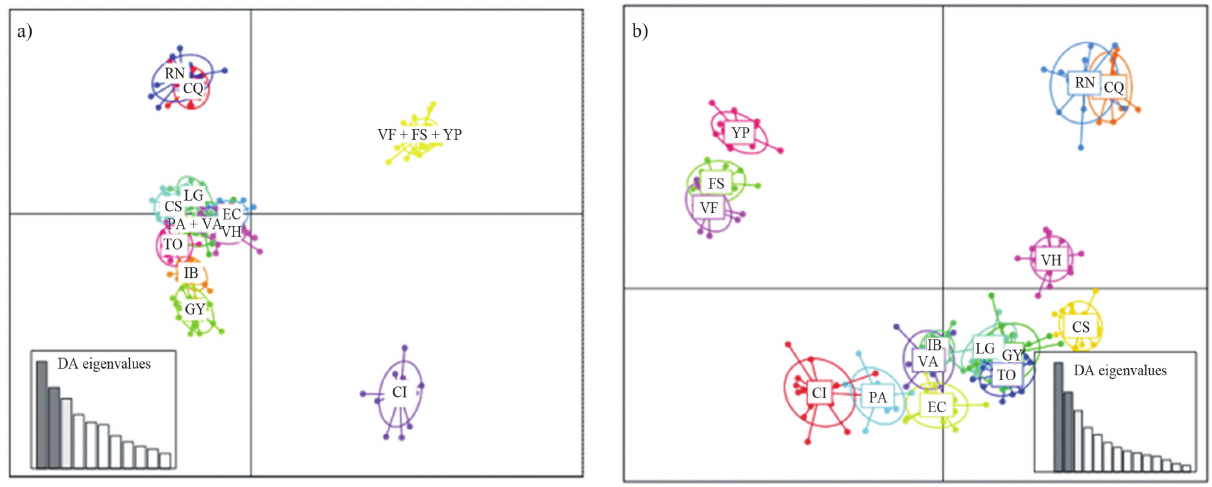
Figure 4 - Scatterplot of individuals on the two principal components of DAPC. The graph represents the individuals as dots and the groups as inertia el- lipses. Eigenvalues of the analysis are displayed in inset: a) obtained with the find.clusters option, b) with clusters defined a priori according to the sam- pling site. Population codes are given in Table 1.